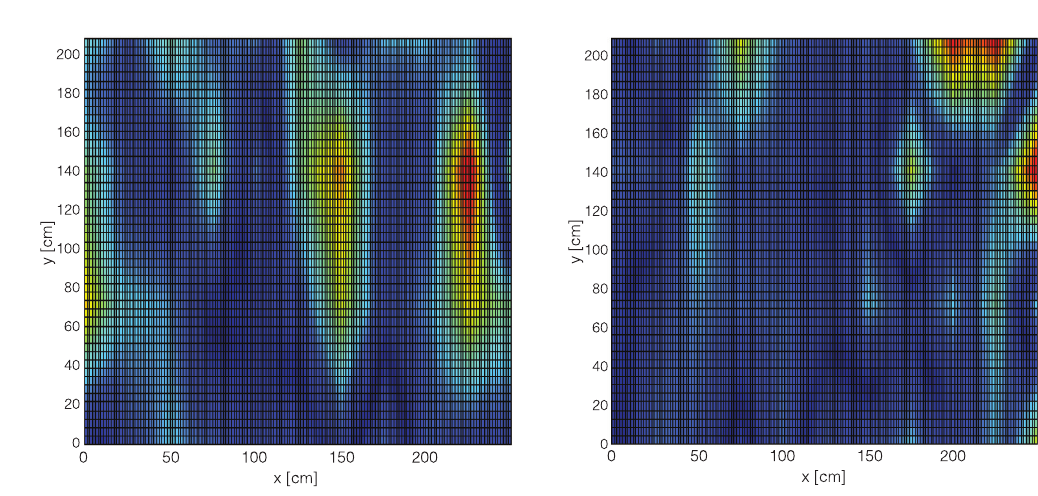
Fig. 13. Horizontal slice at 12 ns under the Roman road (square A).